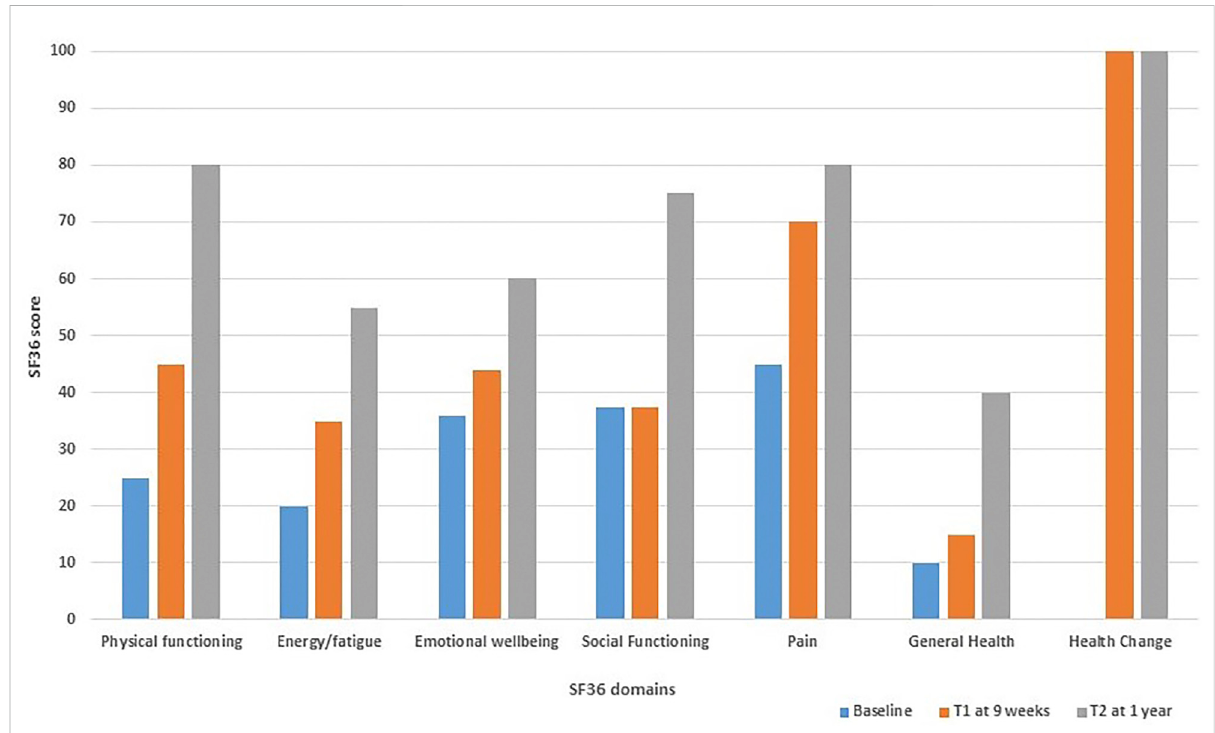
FIGURE 5 Barchartdemonstratingthe36itemShortForm(SF36)healthrelatedqualityoflifescoreforpatientB;completedatbaselinebeforeTrametinib (baseline), week 9 after commencing Trametinib (T1) and at 1 year follow up